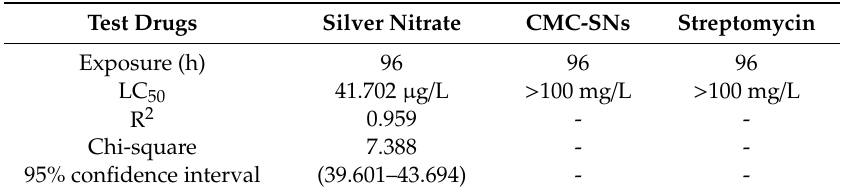
Table 3. LC 50 values of silver nitrate, CMC-SNs and streptomycin to zebrafish.